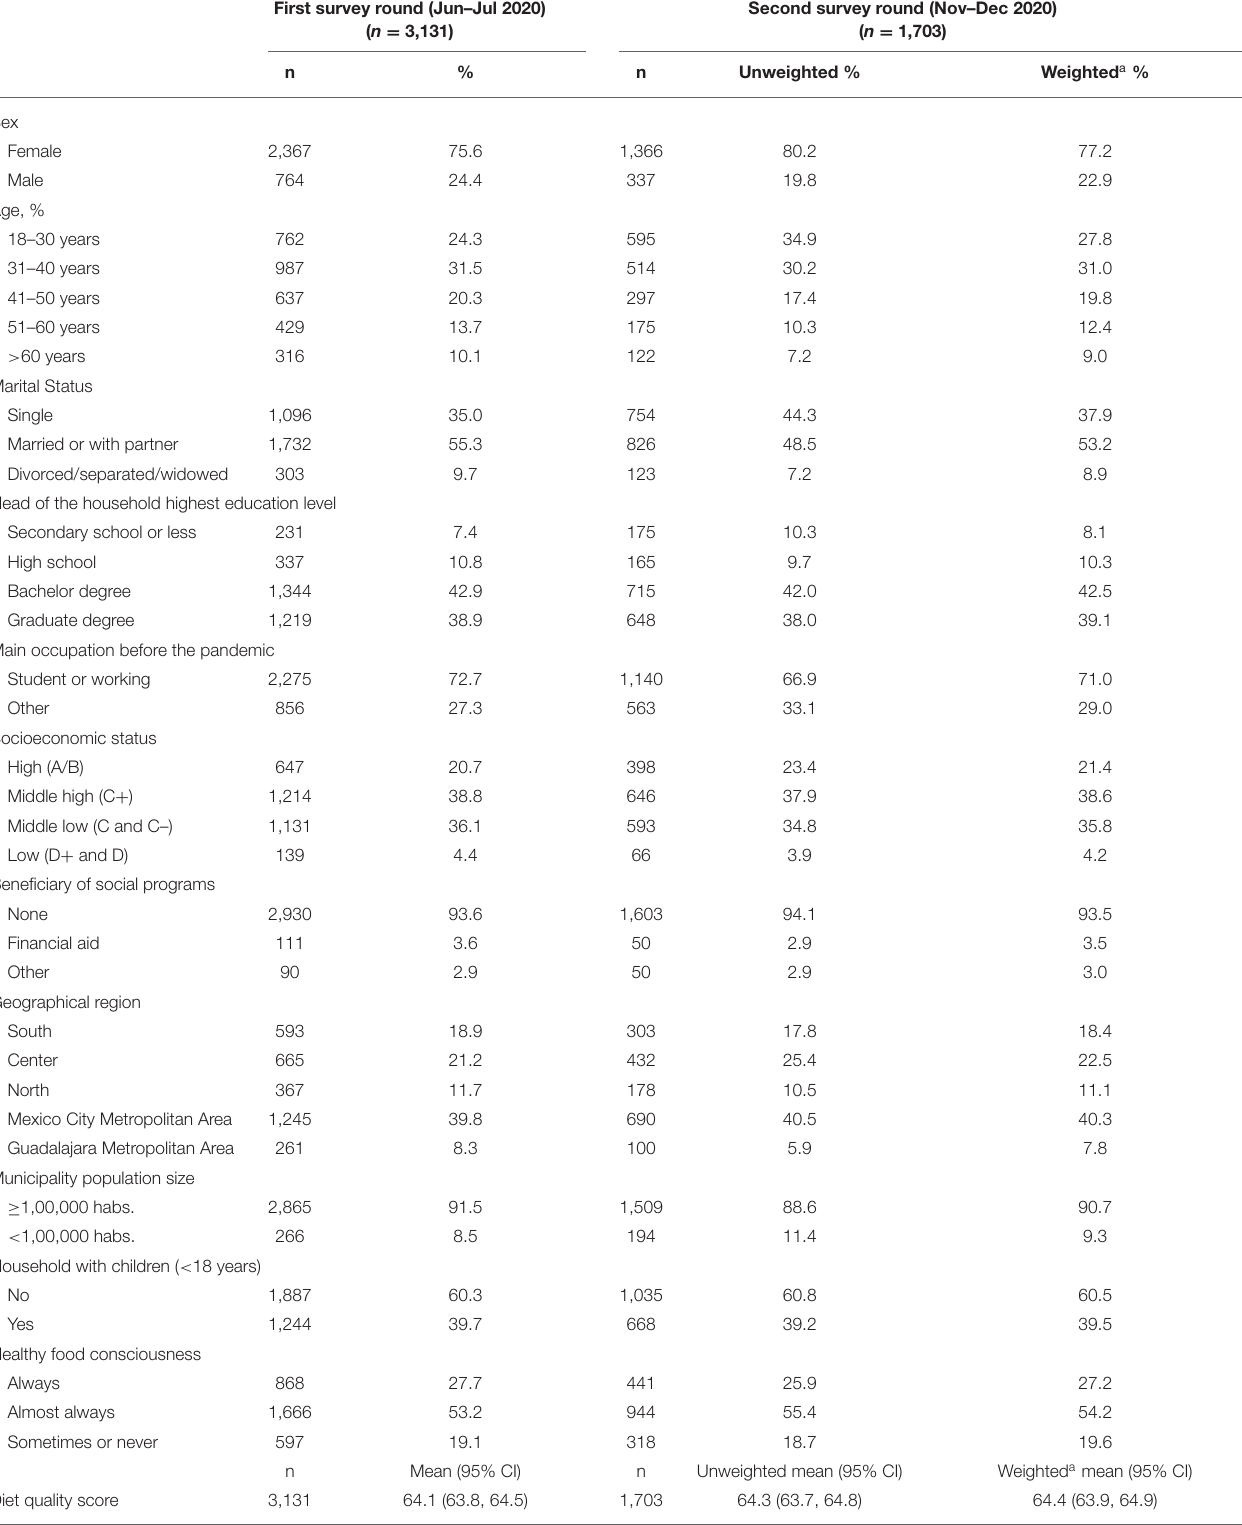
TABLE 1 | Sociodemographic and individual characteristics and mean diet quality